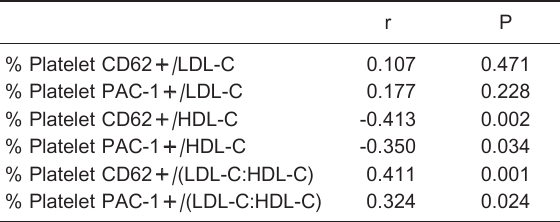
Table 4. Correlation between platelet activation markers and lipid parameters among the patients with high levels of LDL-C.